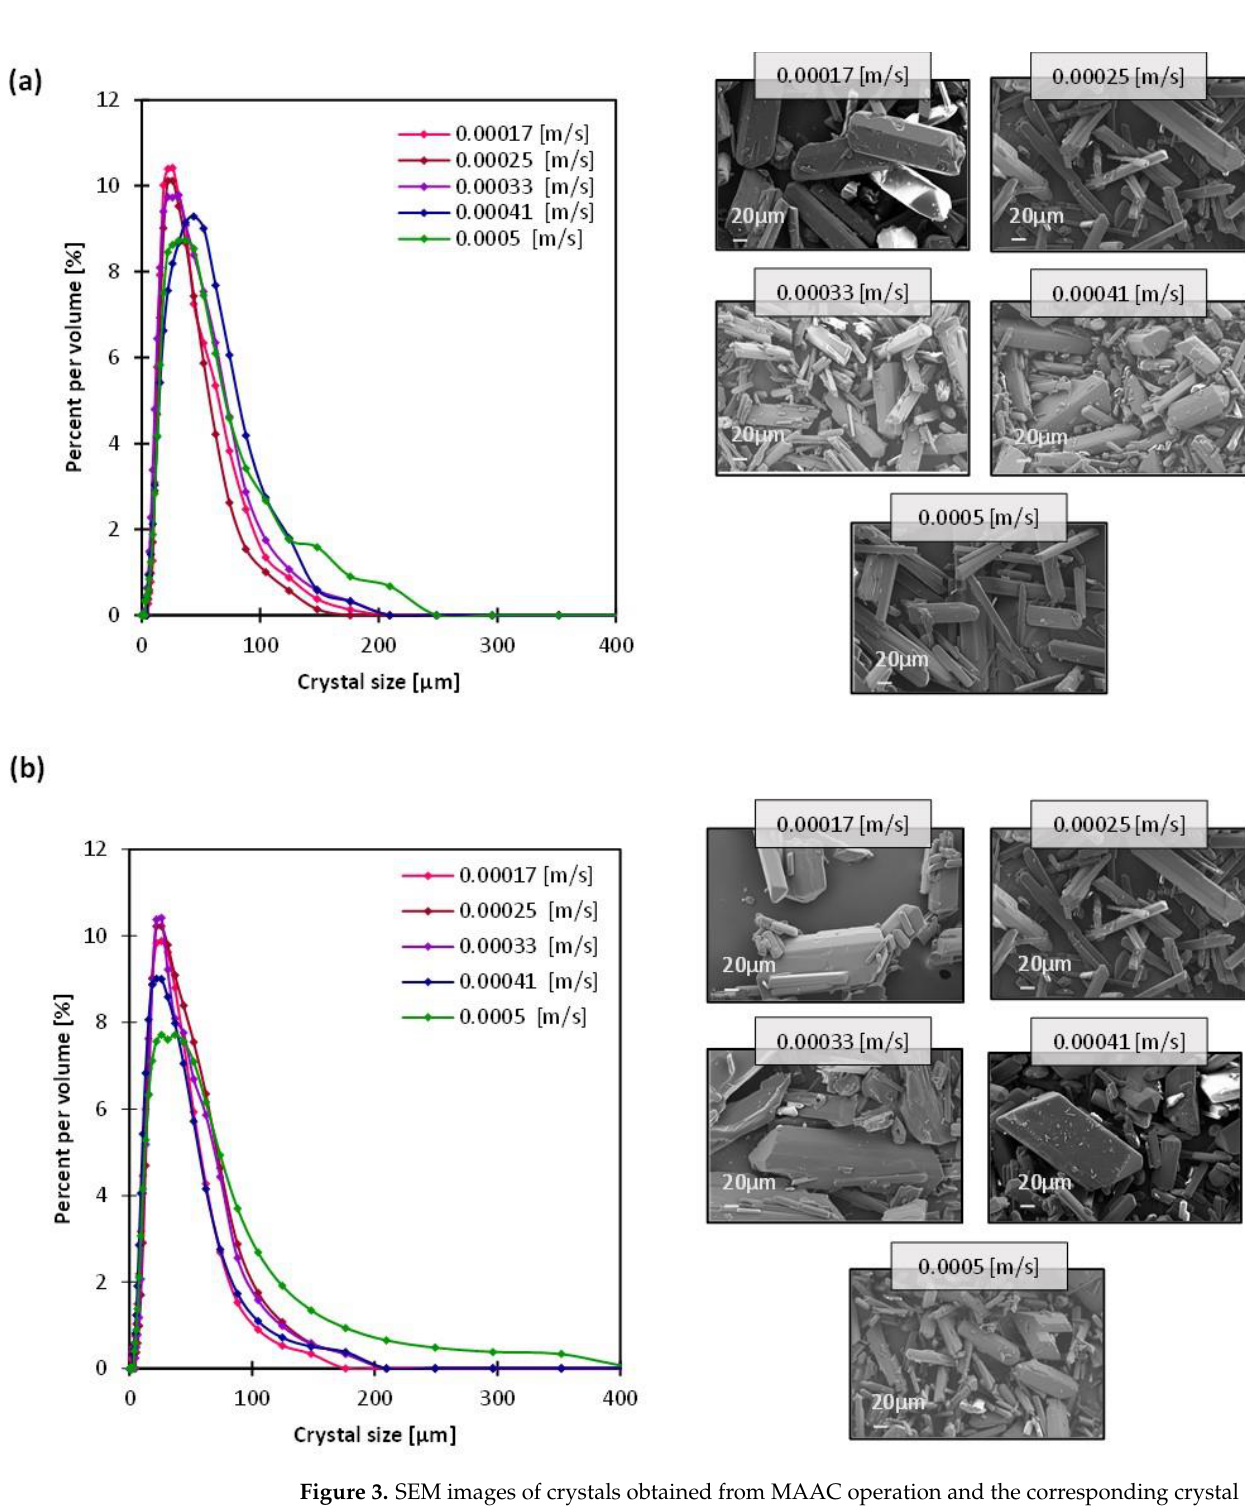
Figure 3. SEM images of crystals obtained from MAAC operation and the corresponding crystal size distribution, at incremental velocities of ( a ) the crystallizing solution and ( b ) the antisolvent